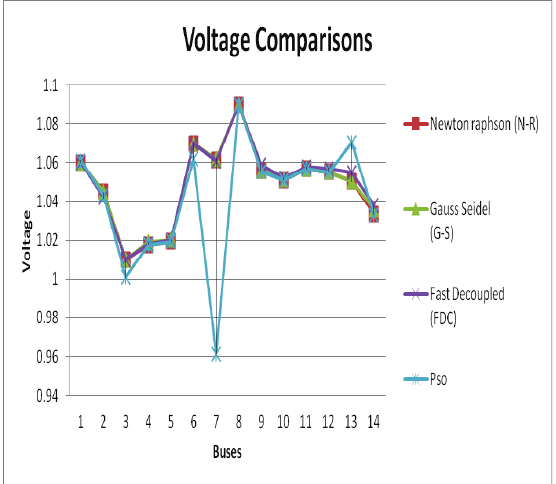
Fig.9. Voltage magnitude comparison